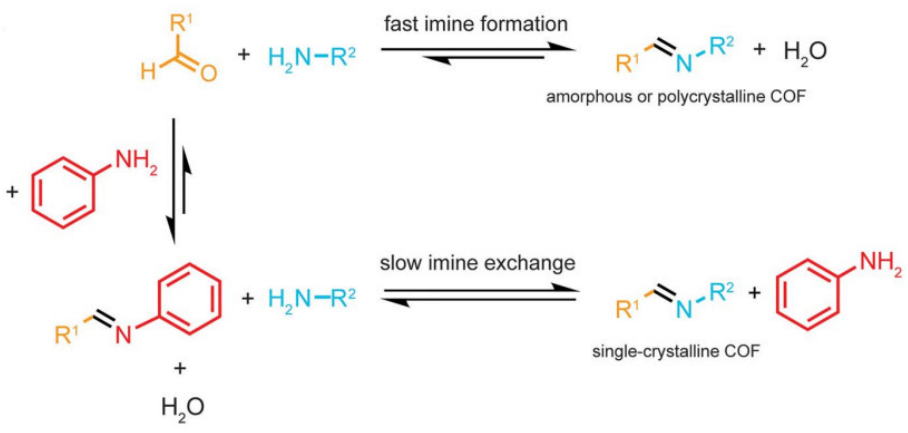
Figure 5. Aniline as a modulator for controlling the reversibility of the reaction [38].